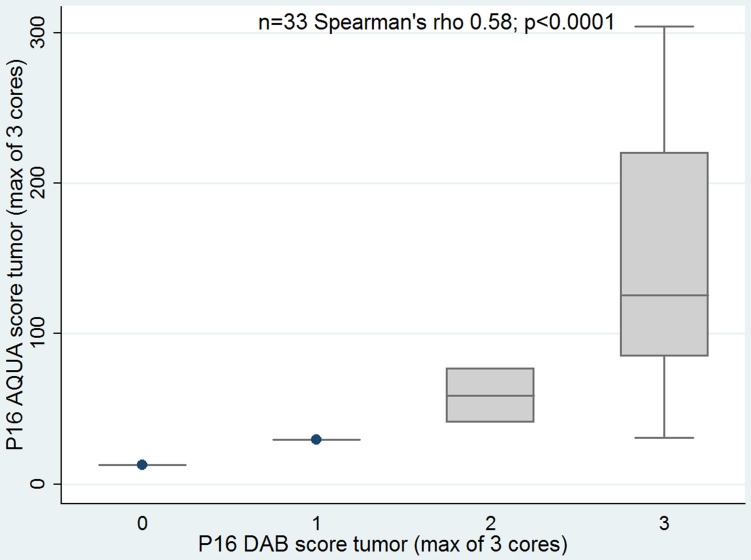
p16 evaluated by DAB and AQUA.DAB: conventional p16 diaminobenzydene.